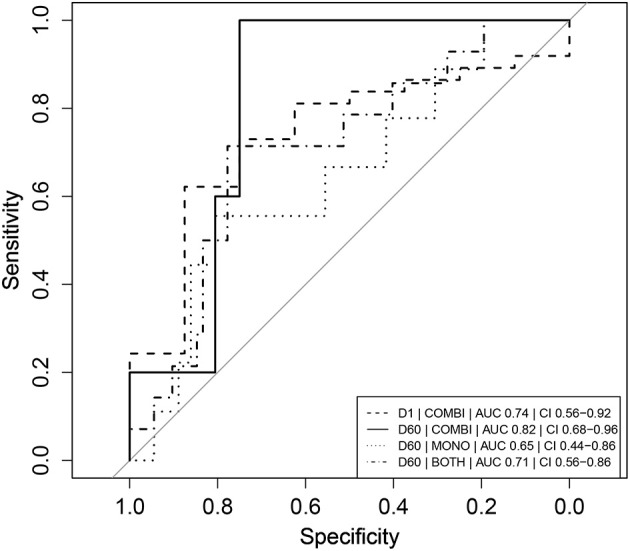
Receiver operator characteristic (ROC) curves of absolute neopterin concentrations as predictors of clinical relapse. Combination therapy is indicated as “COMBI,” monotherapy as “MONO” and data of the two arms combined as “BOTH.” AUC represents the integrated area under the ROC curve. CI refers to the confidence interval of the calculated AUC. Note that day 1 (D1) neopterin concentrations are evaluated as predictor of cure (cure = 1, relapse = 0) and day 60 (D60) neopterin concentrations are evaluated as predictor of relapse (relapse = 1, cure = 0).